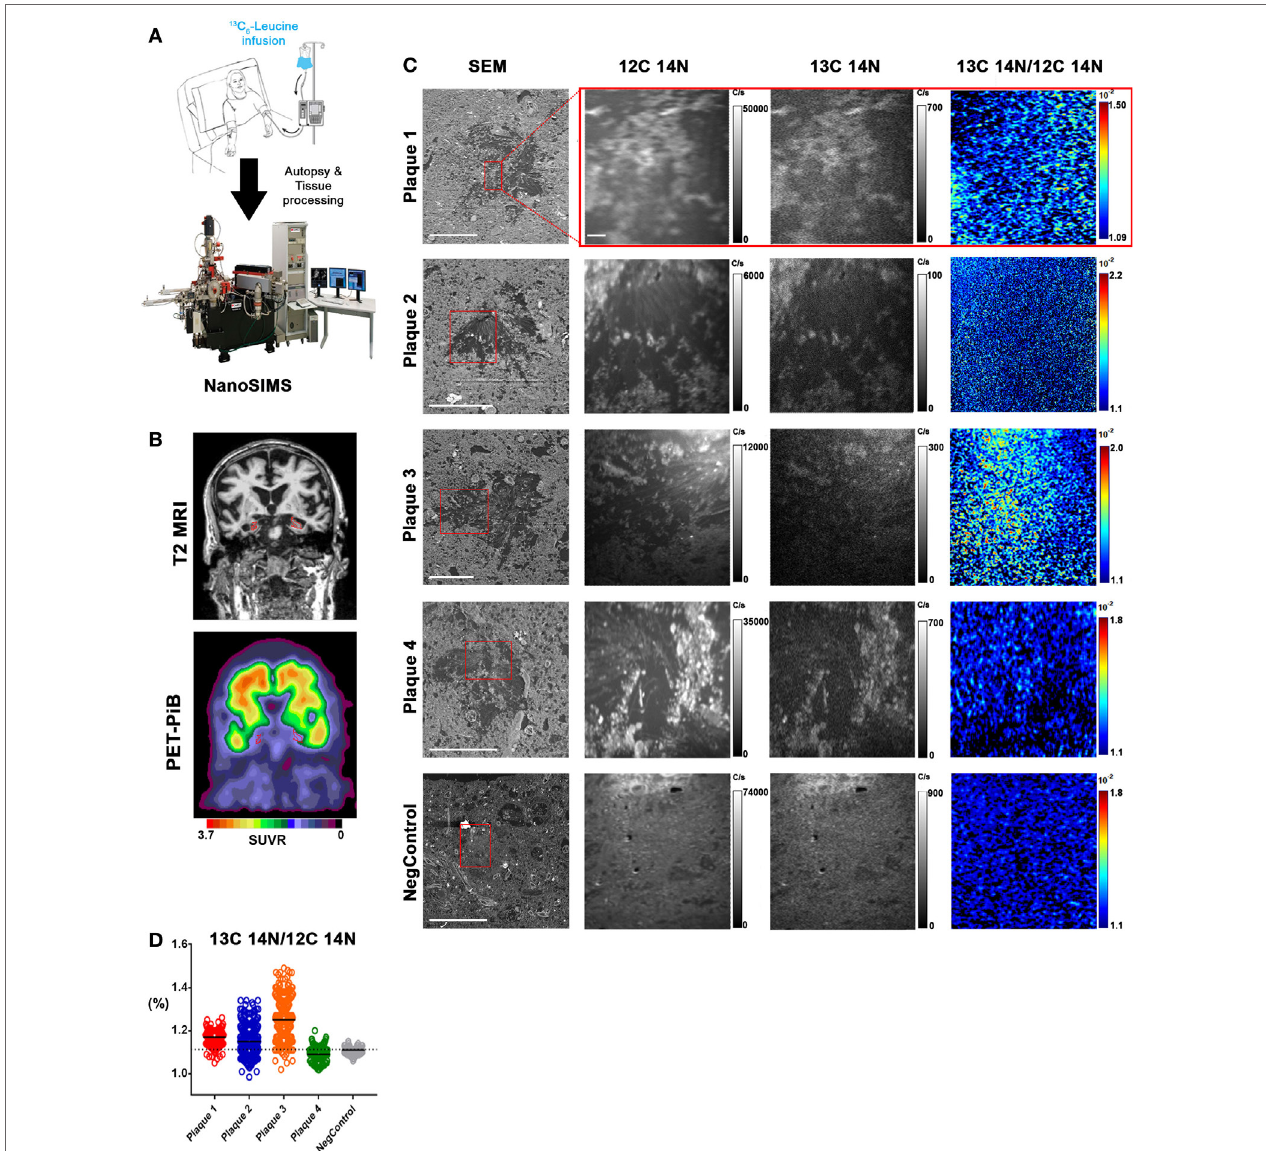
FigUre 3 | In vivo stable isotope incorporation of 13 C within plaques in the frontal lobe of clinically and pathologically confirmed Alzheimer’s disease brain. (a) Primary question: are amyloid- β plaques dynamic structures able to incorporate the stable isotope tracer 13 C 6 -leucine and can this be directly measured in the human brain? (B) Traditional imaging of SILK Pt2 by T2-weighted magnetic resonance imaging (MRI) ( upper ) and by PET-PiB ( lower ) in a coronal view. Hippocampal atrophy ( red ) in the MRI image is apparent along with prominent PiB binding in the PET image. SUVR, standardized uptake value ratio. (c) Four diffuse plaques in the frontal lobe of SILK Pt2 and a dense core plaque from the frontal lobe of non-SILK Pt1 ( Table 2 ). From left to right, scanning electron microscope (SEM) image of the plaque (red box defines area imaged by SILK–SIMS), 12 C 14 N ion map, 13 C 14 N ion map, and 13 C 14 N/ 12 C 14 N ion map. (D) Summary scatter plot of all plaque region-of-interest normalized ratios shown below. Horizontal bars represent plaque 13 C 14 N/ 12 C 14 N medians, and dashed horizontal line represents natural abundance of 13 C (1.1%). Scale bar for all SEM images, 40 µm. Scale bar for all SILK–SIMS images, 5 µm. SEM magnification and SILK–SIMS image raster, respectively: Plaque 1: 636X and 25 × 25 μ m; Plaque 2: 1,024 and 35 × 35 μ m; Plaque 3: 628X and 50 × 50 μ m; Plaque 4: 628X and 45 × 45 μ m; NegControl: 600X and 45 × 45 μ